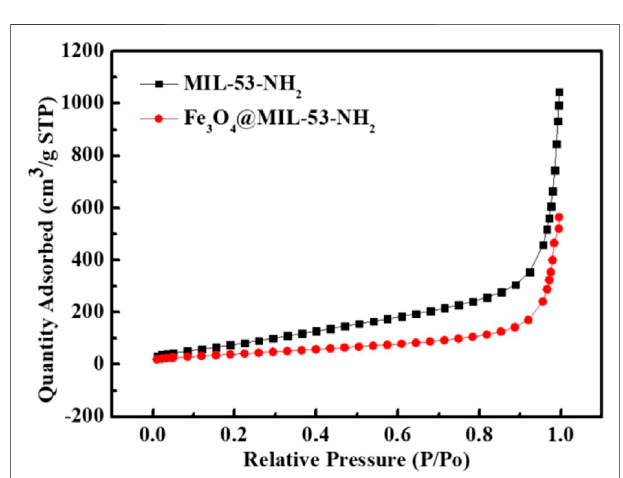
FIGURE4| BETanalysisofMIL-53(Al)-NH 2 andFe 3 O 4 @MIL-53(Al)-NH 2